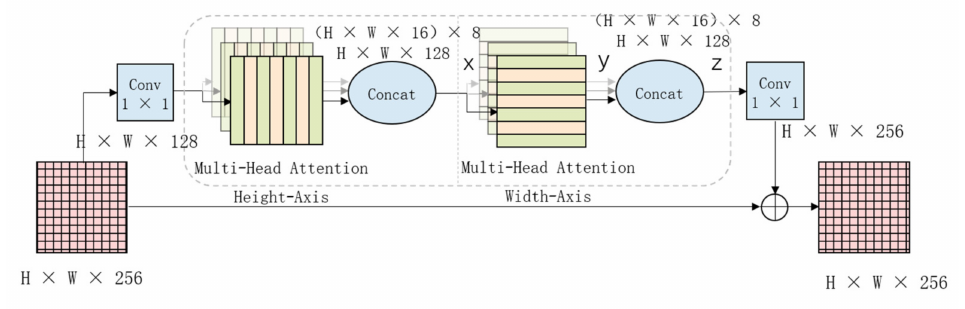
Figure 4. The module of